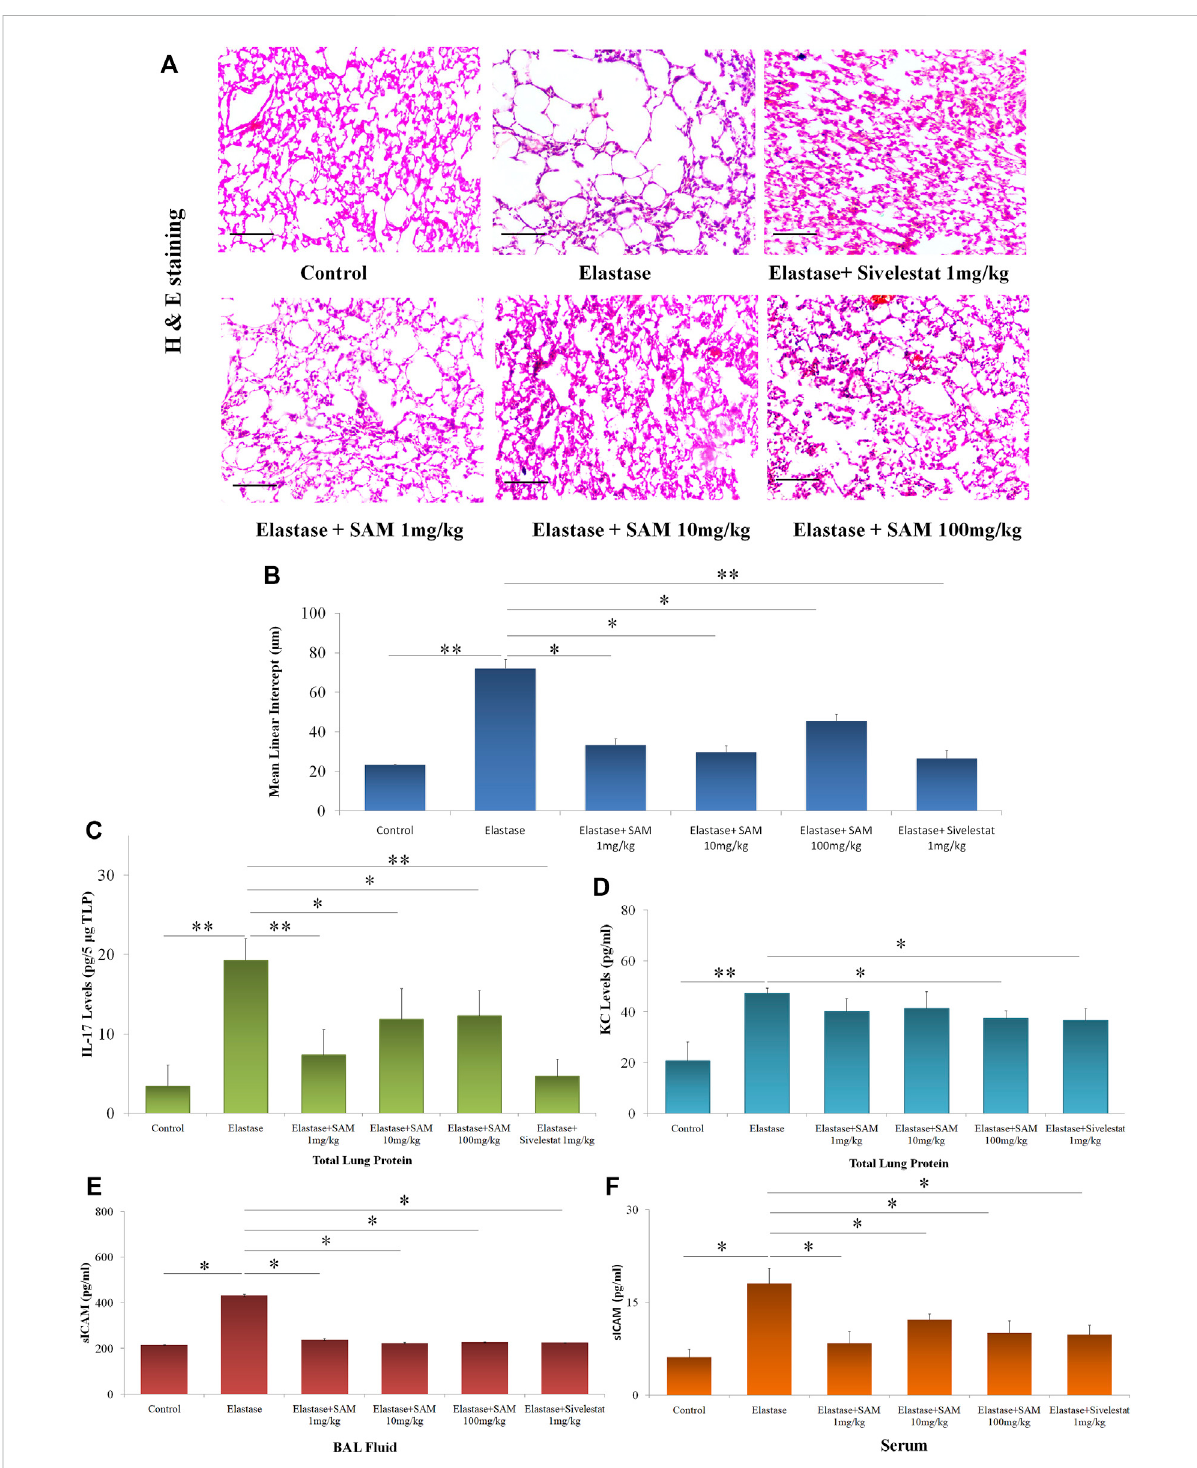
FIGURE 7 S.apetala fruitextractreversesemphysematouschanges invivo (A) HnEStainingofmouselungsectionbeforeandaftertreatmentascompared tocontrolmouse. (B) Meanlinearintercept(MLI)ofmicelungsasassessedfromsectioning. (C) IL-17Aand (D) KClevelsweremeasuredinlungtissue homogenateofmicebyELISA. n =threeto fi vepergroup;* < 0.05comparedtoControl,** < 0.01comparedtoNE. (E) BALsICAMlevelsand (F) serum sICAM levels of elastase and elastase + SAM/Sivelestat treated mice were measured by ELISA as compared to control. All experiments were conducted thrice (* p <